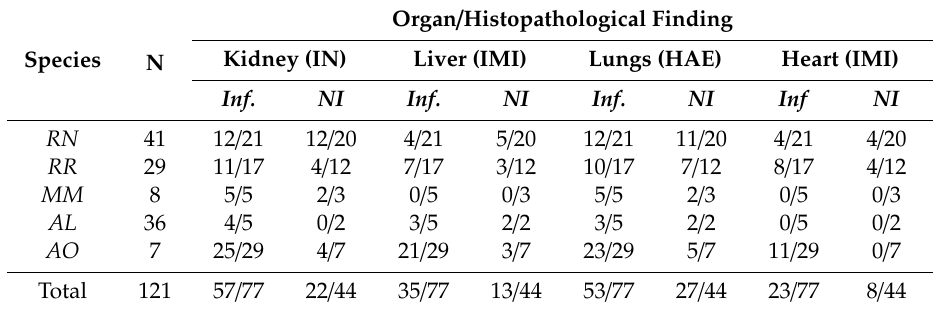
Table 6. Infection status by pathogenic Leptospira and histopathological findings by species in rodents trapped in dairy farms in the Los R í os Region,